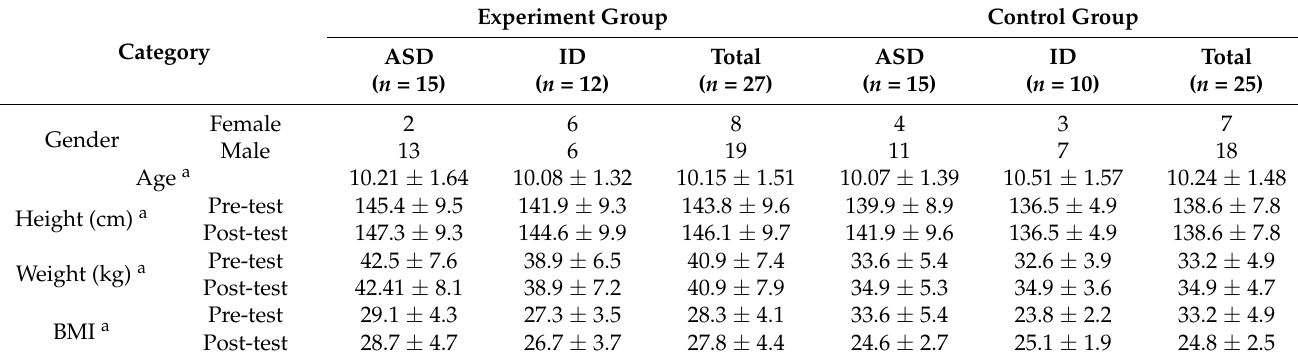
Figure 2. Ball skill simulation and actual execution in ICT-based exergame. Table 2. Demographic characteristics of the